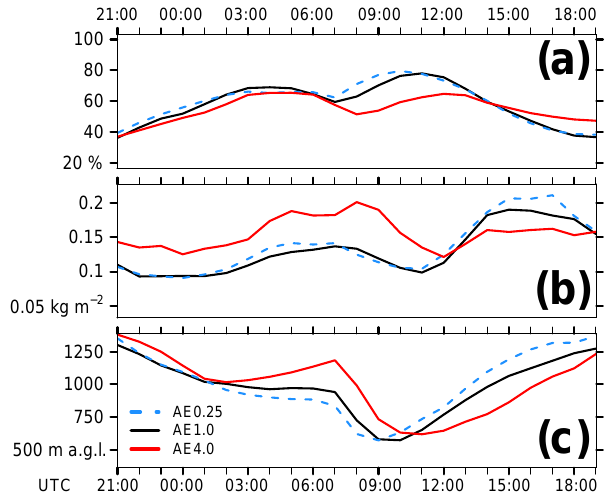
Figure 17. Spatial average (8 ◦ W–3.5 ◦ E, 5–10 ◦ N) of (a) total cloud cover (%), (b) total cloud water (kg m − 2 ) and (c) cloud base height (ma.g.l.) for the temporal evolution between 2 July 21:00UTC and 3 July 19:00UTC. The cloud cover is detected by nonzero values of total cloud water. A value of 60% denotes that 60% of the domain is covered by clouds. For the spatial average of total cloud water, values below 10gm − 2 were omitted. The cloud base height is detected via the lowest height above ground level with a nonzero cloud water value. The blue dashed, black solid and red solid lines denote the clean, reference and polluted case, respec-